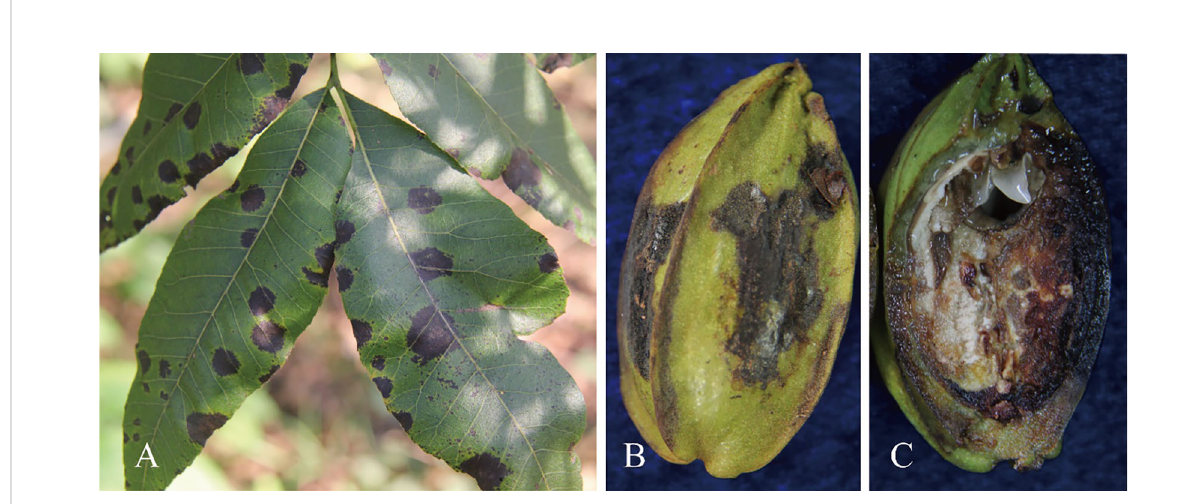
FIGURE 1 Visible symptoms caused by Colletotrichum spp. on pecan. (A) Irregular necrotic spots on leaves. (B) Irregular grey lesions on the pericarp. (C) Internal symptoms in the